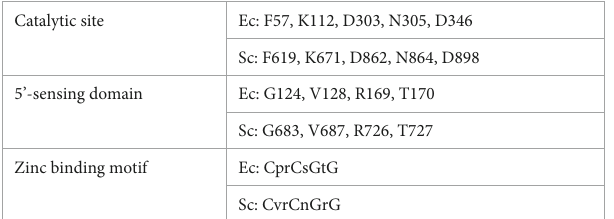
TABLE 1 Conserved amino acids in the domains of E. coli (Ec) RNase E and S. coelicolor (Sc) RNase ES. Catalytic